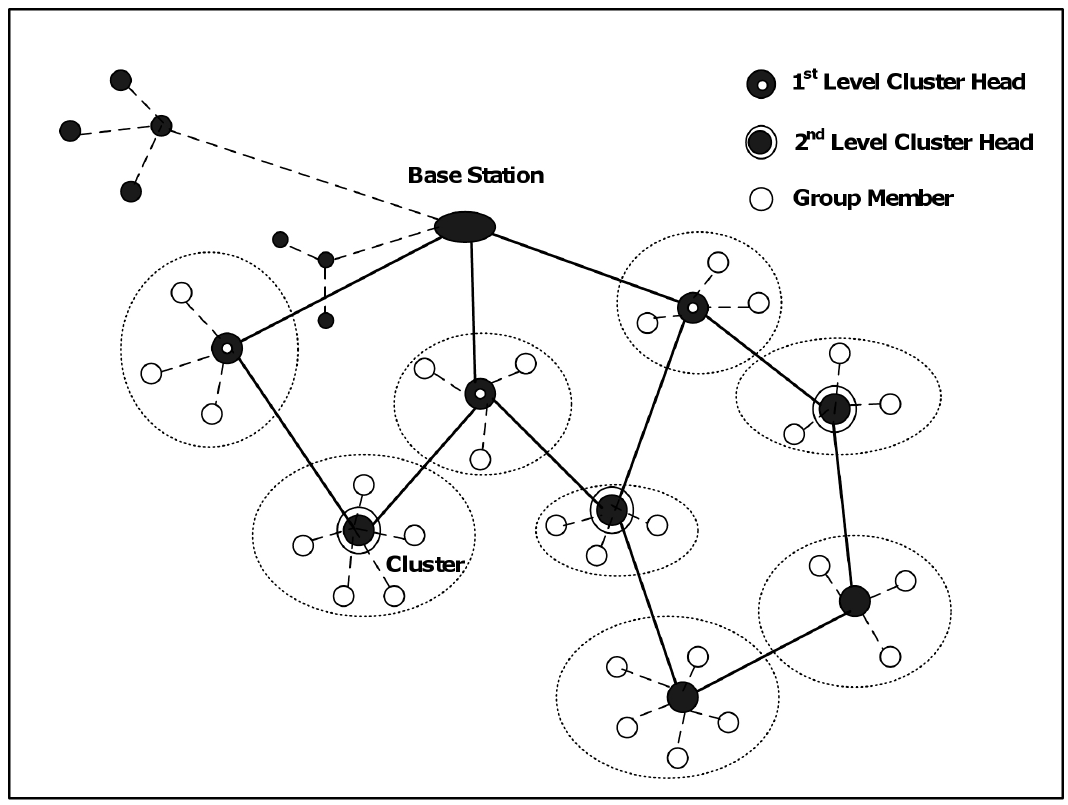
Figure 2. A Simple Example of Cluster-Based Multipath